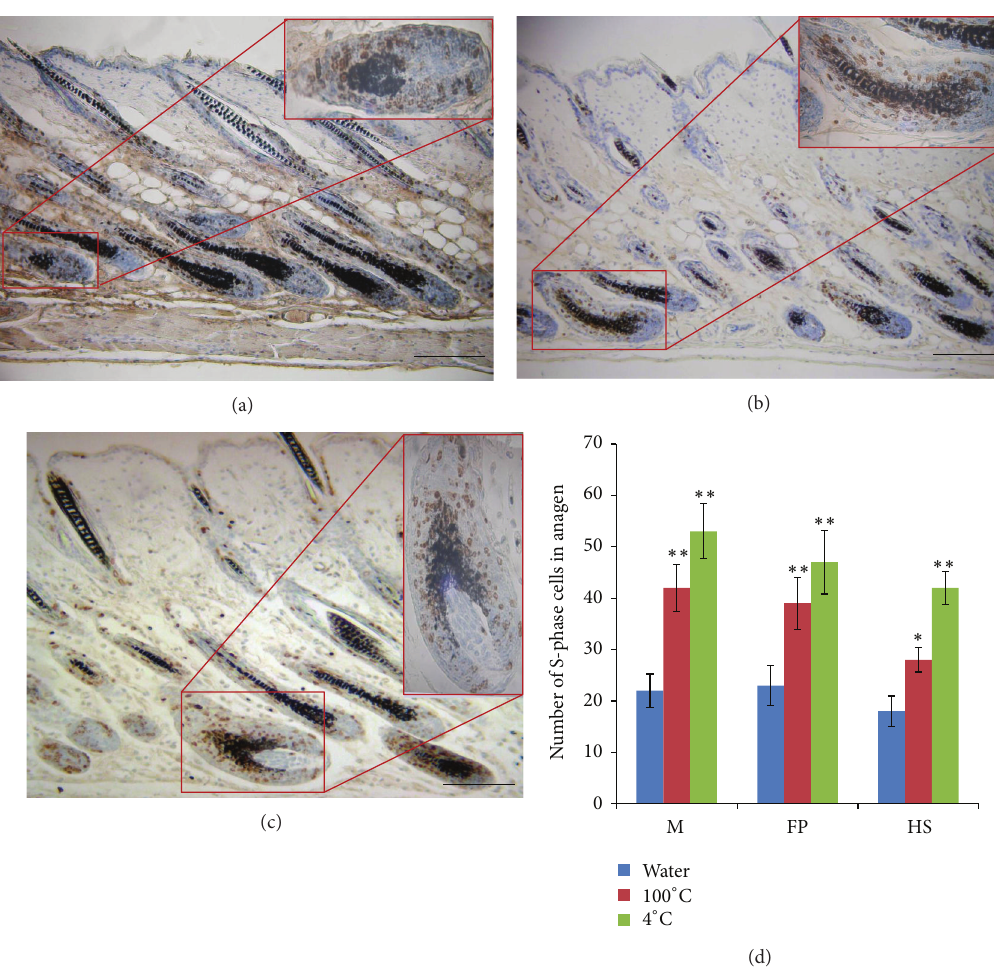
Figure 3: Immunohistochemical staining of BrdU incorporation in S-phase in anagen. ((a)–(c)) Paraffin sections from a 7-week-old C57BL/6 mouse injected with bromodeoxyuridine 48h before necropsy, at magnification 100x. LRC could be seen in the matrix and the follicle papilla after labeling during the onset of anagen. Note the high proliferation rate (number of brown nuclei) in AAE-treated animals ((b) and (c)) compared to the control (a), with (d) showing the number of S-phase cells during anagen phase in different hair follicle regions. M: matrix, FP: follicle papilla, and HS: hair shaft. Scale bars are 100 𝜇